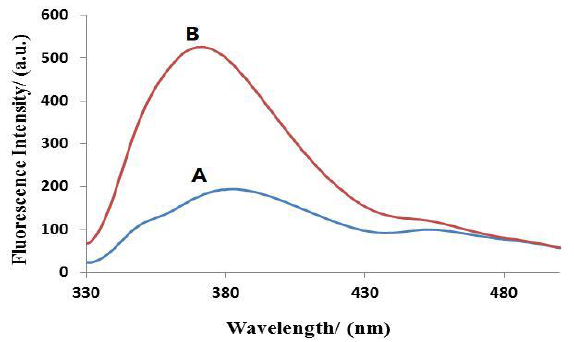
Figure 2. Validation of microRNA (miRNA) detection by the proposed method. Fluorescence emission spectra obtained when ( A ) no target miRNA and ( B ) 200 nM target miRNA were used in the reaction.